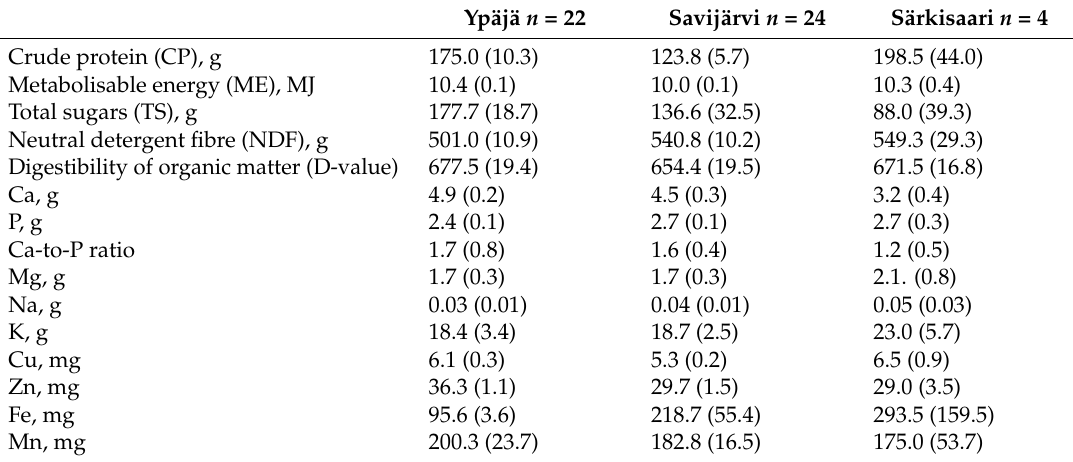
Table 2. Means ( ± SE) of feed values and nutrient composition of the pasture grass for the whole period of measurements (8 June–24 September 2012). All values are per kg of dry matter. Samples were taken within grazed parts of a pasture and plant species strictly avoided by the horses were discarded.